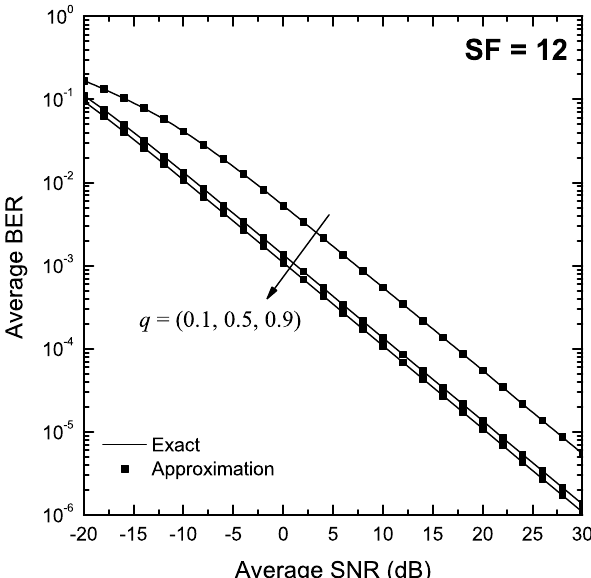
Figure 8. BER of LoRa systems operating in the presence of Hoyt fading as a function of the SNR, γ , for SF = 12 and various values of q